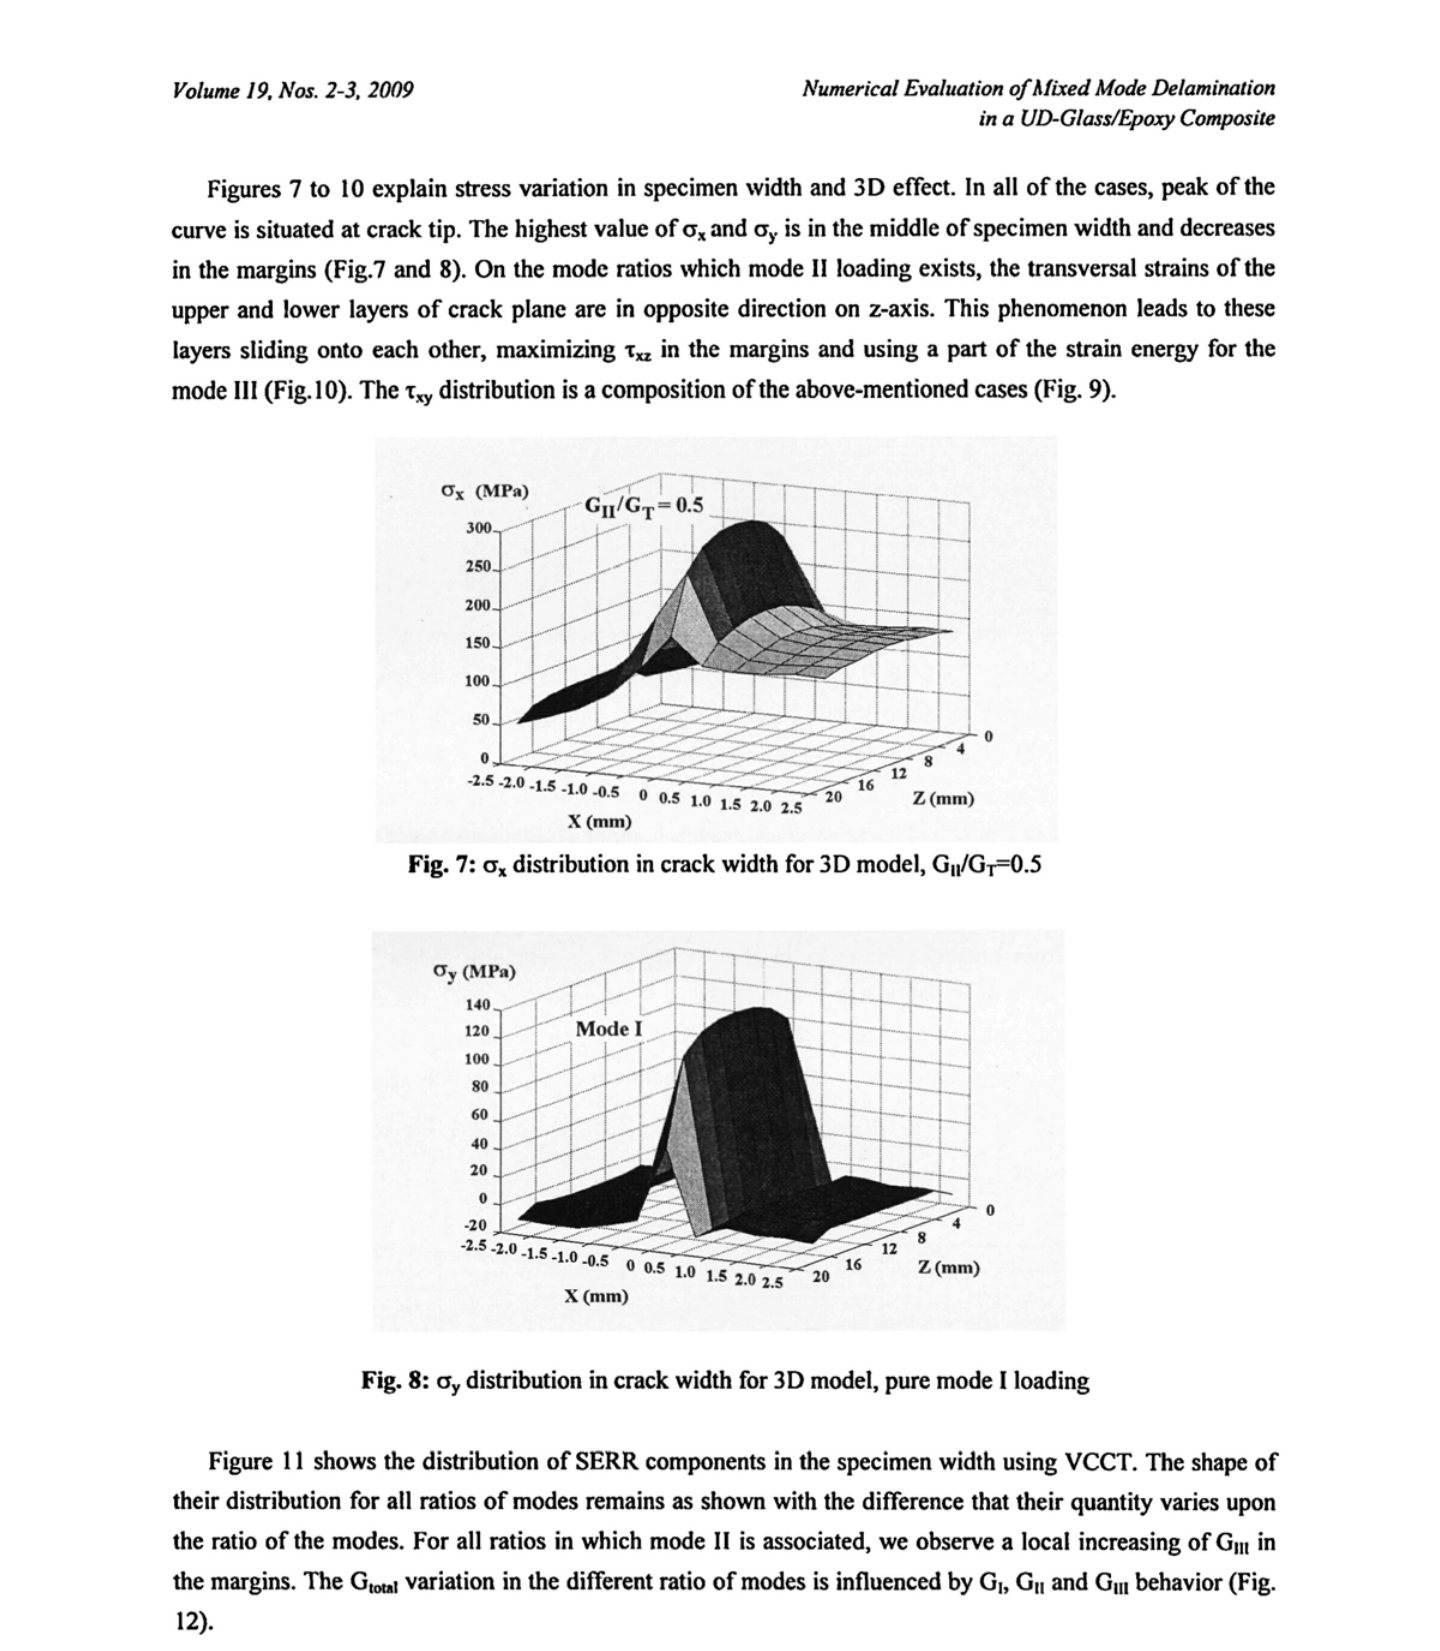
Fig. 8: σ distribution in crack width for 3D model, pure mode I γ